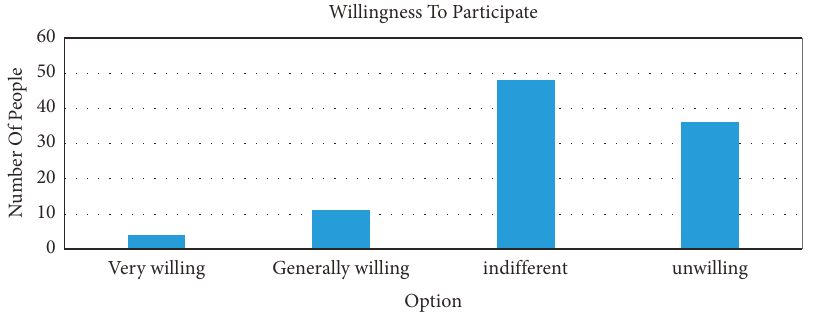
Figure 8: Willingness to participate in school mental health education.